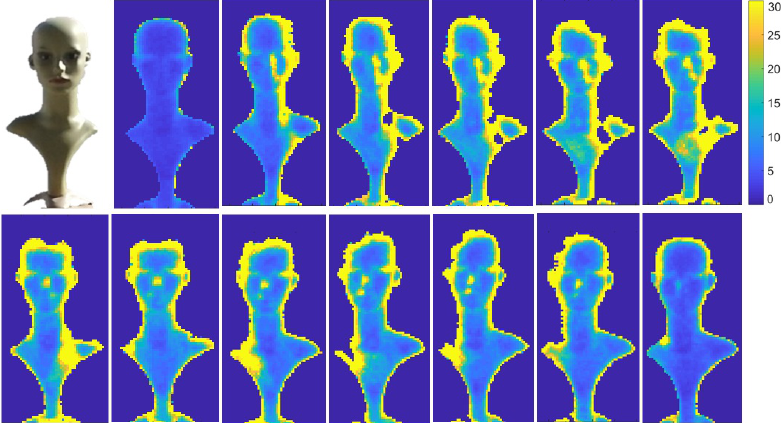
Figure 13. RGB image of a doll ( top left ) and noise images of the doll sequence captured by a KinectV2 camera, under sunlight every hour from 6am ( top left ) to 6pm ( bottom right